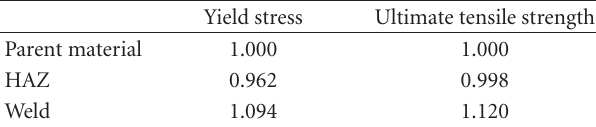
Table 3: Mechanical properties of Hastelloy-X alloy. Table 4: Normalized mechanical properties of Hastelloy-X